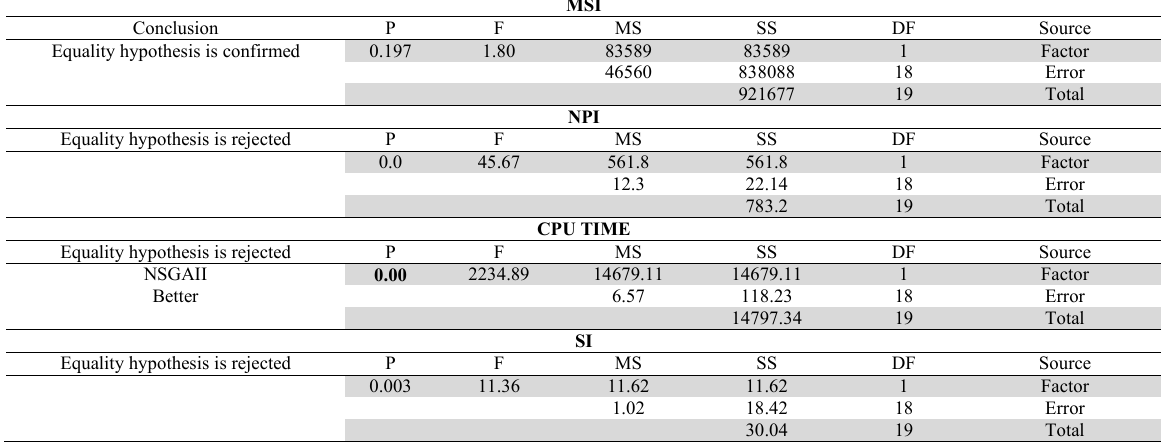
The summary of the results of one-way ANOVA test on NSGA II versus MOPSO for small sizes